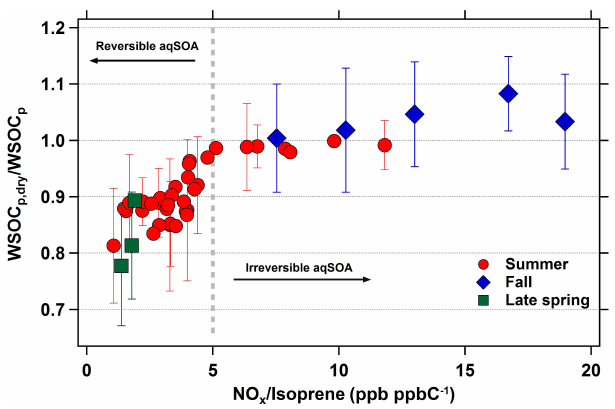
Figure 7. Daily average WSOC p , dry / WSOC p ratios as a func- tion of daily average NO x / isoprene ratios (ppbppbC − 1 or mol(molC) − 1 ). Gray dotted line is representative of the transition zone from reversible to irreversible aqSOA conditions. Error bars represent ± 1 σ , and are shown for one-third of the summertime data for